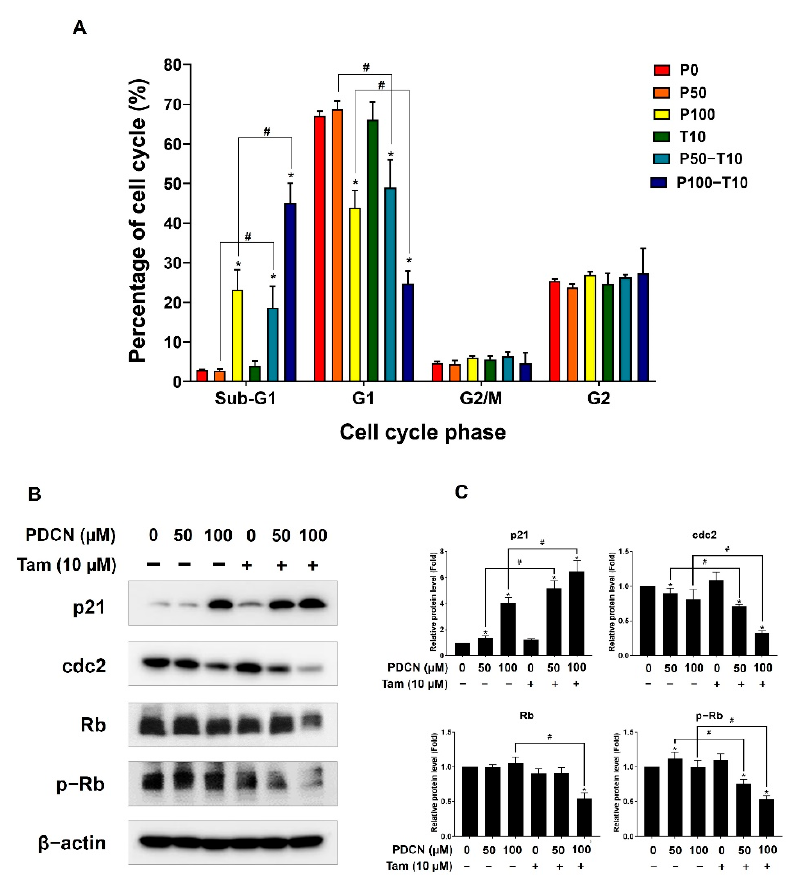
Figure 4. Effect of combined treatment with pentadecanoic acid and tamoxifen on the cell cycle. ( A ) Cell cycle analysis of MCF − 7/SC exposed to pentadecanoic acid, tamoxifen, or their combination for 48 h. ( B , C ) The levels of cell cycle markers were assessed by Western blot experiments following treatment with pentadecanoic acid, tamoxifen, or their combination for 48 h in MCF − 7/SC. β− actin was considered a loading control. The asterisk (*) indicates a p < 0.05 vs. control. The hash mark (#) indicates a p < 0.05 comparing combined treatment vs. individual treatment. P0, P50, or P100: the doses of pentadecanoic acid at 0 μ M, 50 μ M, or 100 μ M. T10: the dose of tamoxifen at 10 μ M. PDCN: pentadecanoic acid; Tam: tamoxifen. Data are representative of three biologically independent experiments and values are shown in mean ± SD.